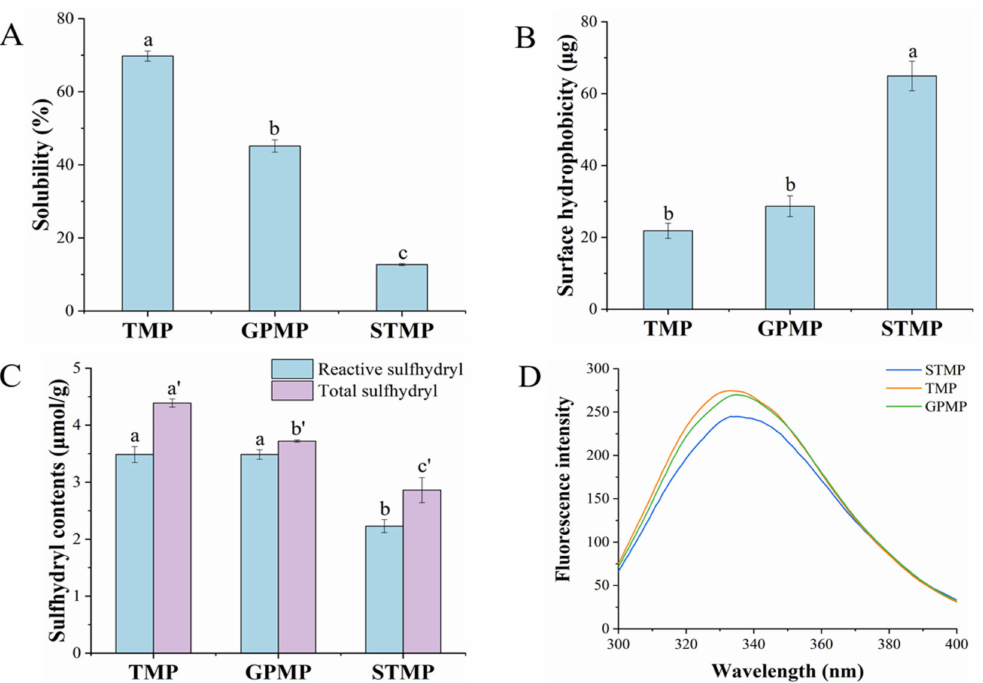
Figure 2. Solubility ( A ), surface hydrophobicity ( B ), total and reactive sulfhydryl (SH) group content ( C ) and intrinsic fluorescence spectra ( D ) of MPs. Different lowercase letters indicate signifi- cant differences at p <